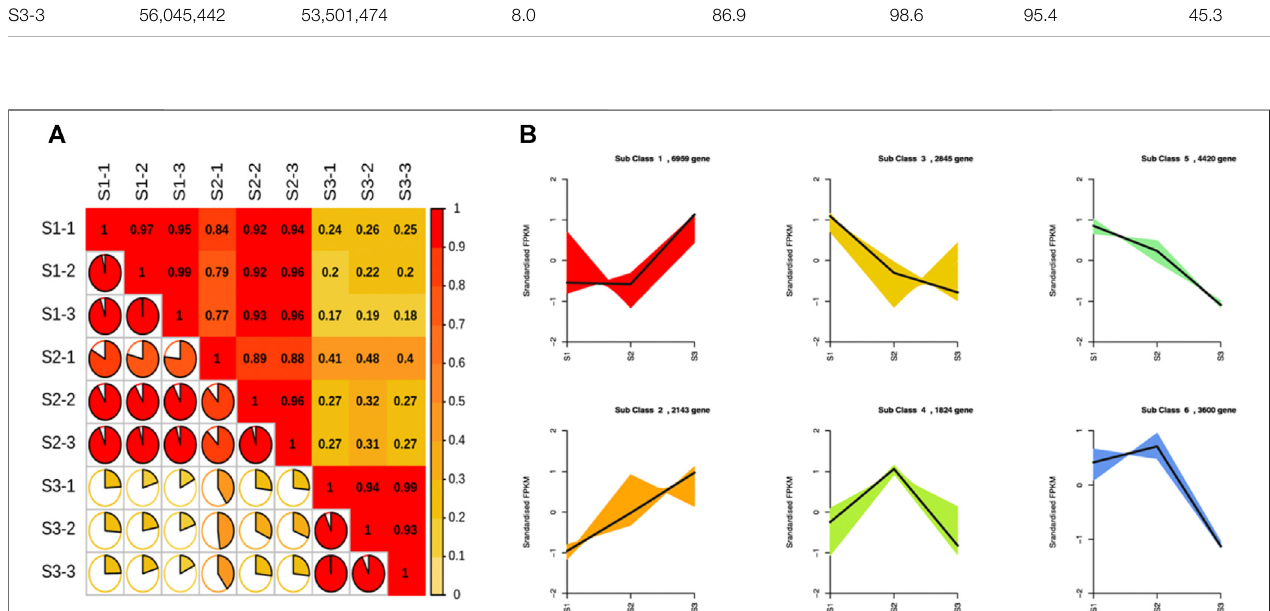
FIGURE 4 | Correlation analysis and K-means clustering of unigenes at three developmental stages of M. ternifolia nutshell (A) Correlation analysis (B) K-means clustering of unigene.